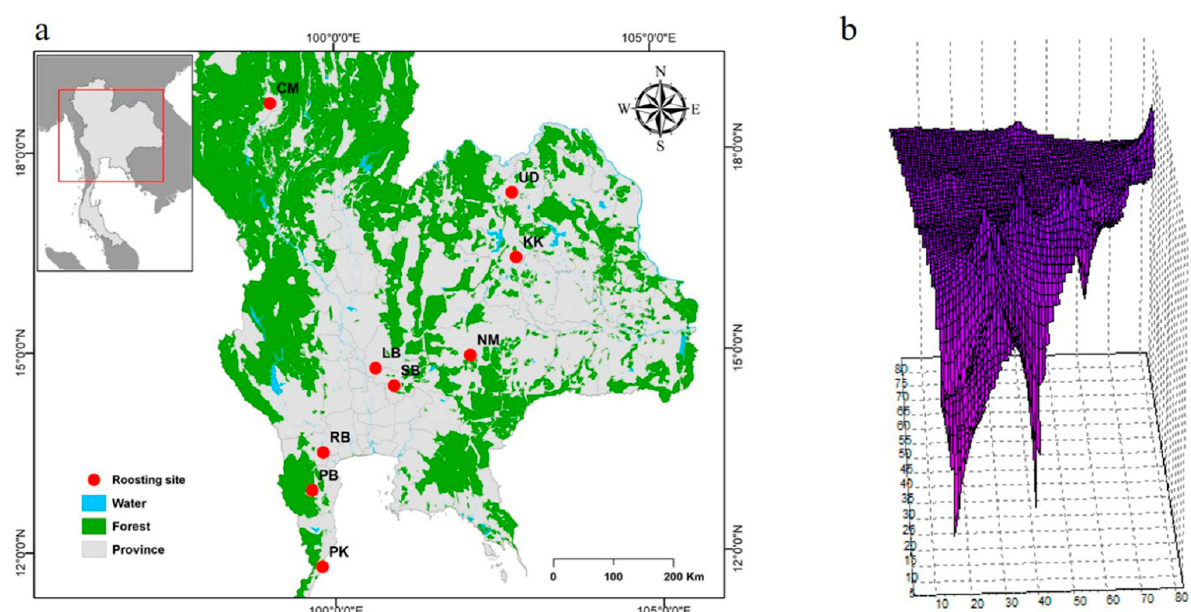
Figure 2. Geographic analyses of the Bos taurus data set. ( a ) Geographic distribution of the nine B. taurus populations (Chiang Mai: CM; Khon Kaen: KK; Lopburi (LB); Nakhon Ratchasima: NM; Phetchaburi: PB; Prachuap Kiri Khan: PK; Ratchaburi: RB; Saraburi: SB; and Udon Thani: UD). ( b ) Genetic landscape interpolation plots for mitochondrial D-loop sequence data depicting areas with high or low genetic differentiation based on geographic coordinates. Bright purple indicates low genetic diversities. Low nucleotide diversities within populations located on livestock farms were found in the central region (Lopburi, Phetchaburi, and Ratchaburi). Table 3. Genetic differentiation between the nine populations in Thailand of cattle based on mitochondrial D-loop sequences. G ST , genetic differentiation coefficient; F ST , Wright’s F -statistic for subpopulations within the total population; Φ ST ; N m , gene flow from sequence data and haplotype data; D xy , average number of nucleotide substitutions per site between populations; D a , net nucleotide substitutions per site between